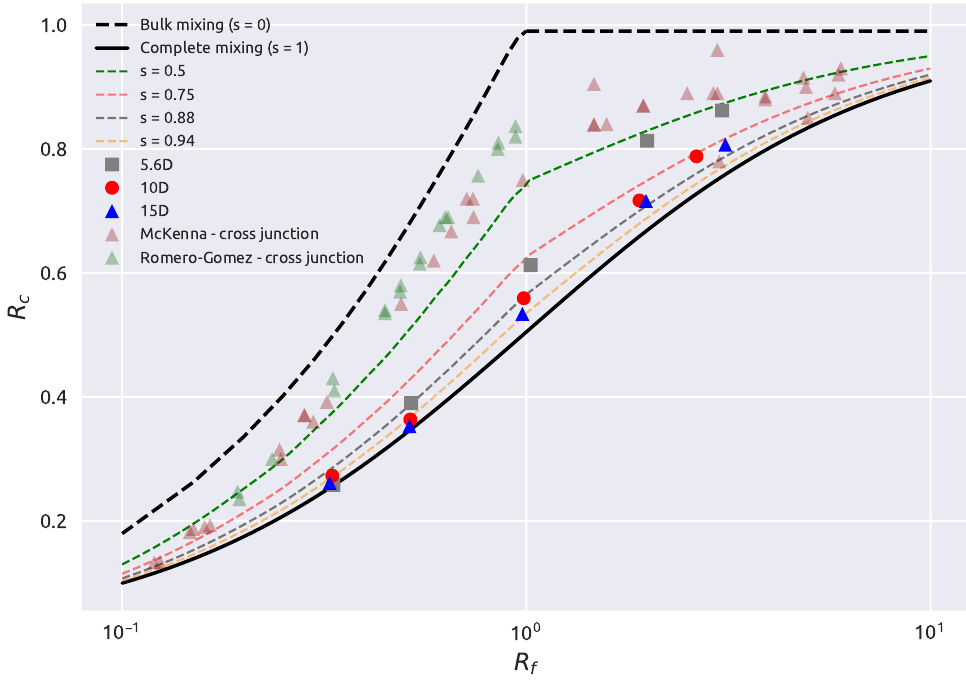
Figure 3. Experimental results for the S configuration—relationship between branch outlet to main inlet pipe conductivity ratio R c and inlet flow ratio R f compared with previous studies [8,9] of cross junction mixing results. Dashed lines represent the value of mixing parameter s used in EPANET-BAM